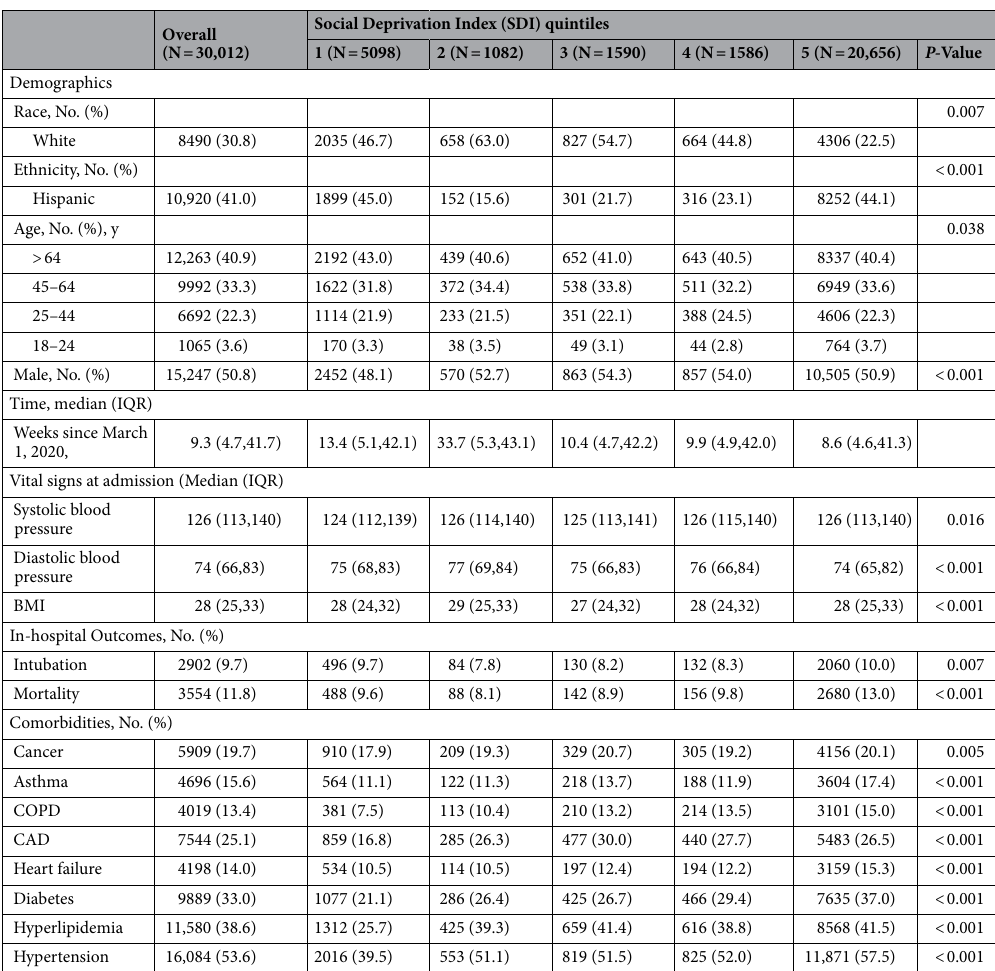
Table 1. Baseline characteristics of hospitalized Covid-19 patients included in the study across SDI (Social Deprivation Index) quintiles. SDI quintiles: 1(Least Disadvantaged), 2(slightly disadvantaged), 3(moderately disadvantaged), 4(more disadvantaged) and 5(most disadvantaged). IQR interquartile range, CAD Coronary Artery Disease, COPD Chronic obstructive pulmonary